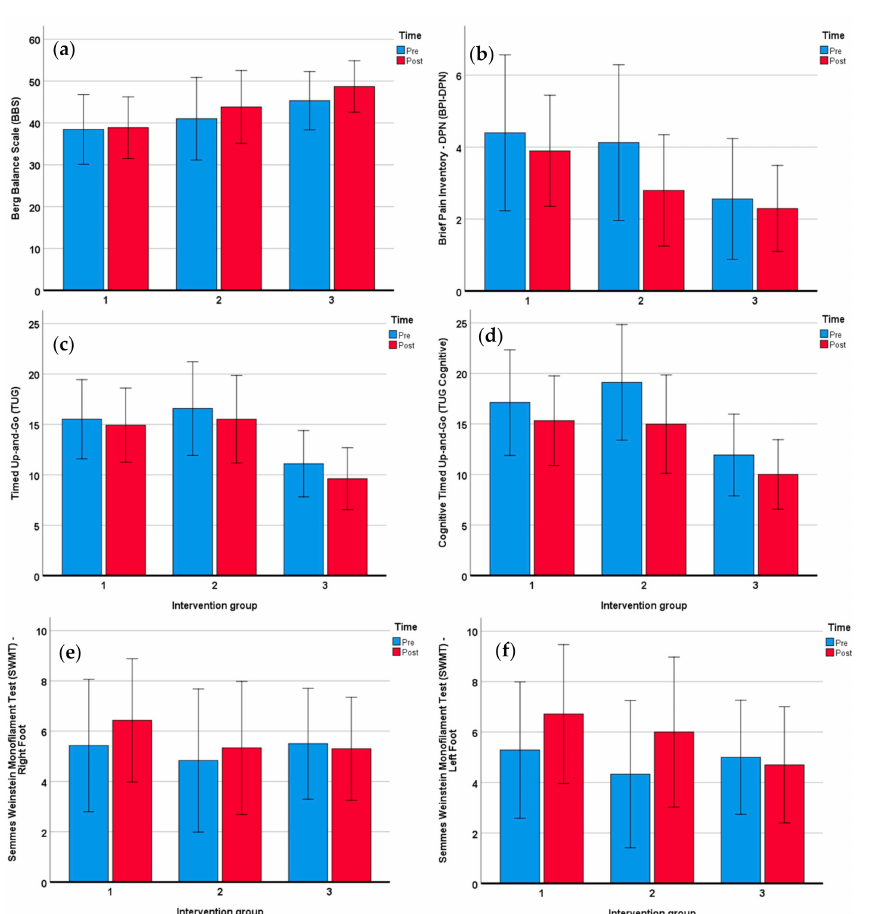
Figure 2. ( a ) Pre- and post-pain scores for each vibration group; ( b ) Pre- and post-balance scores for each vibration group; ( c ) Pre- and post-left foot sensation scores for each vibration group; ( d ) Pre- and post-right foot sensation scores for each vibration group; ( e ) Pre- and post-left TUG scores for each vibration group; ( f ) Pre- and post-TUG cognitive scores for each vibration